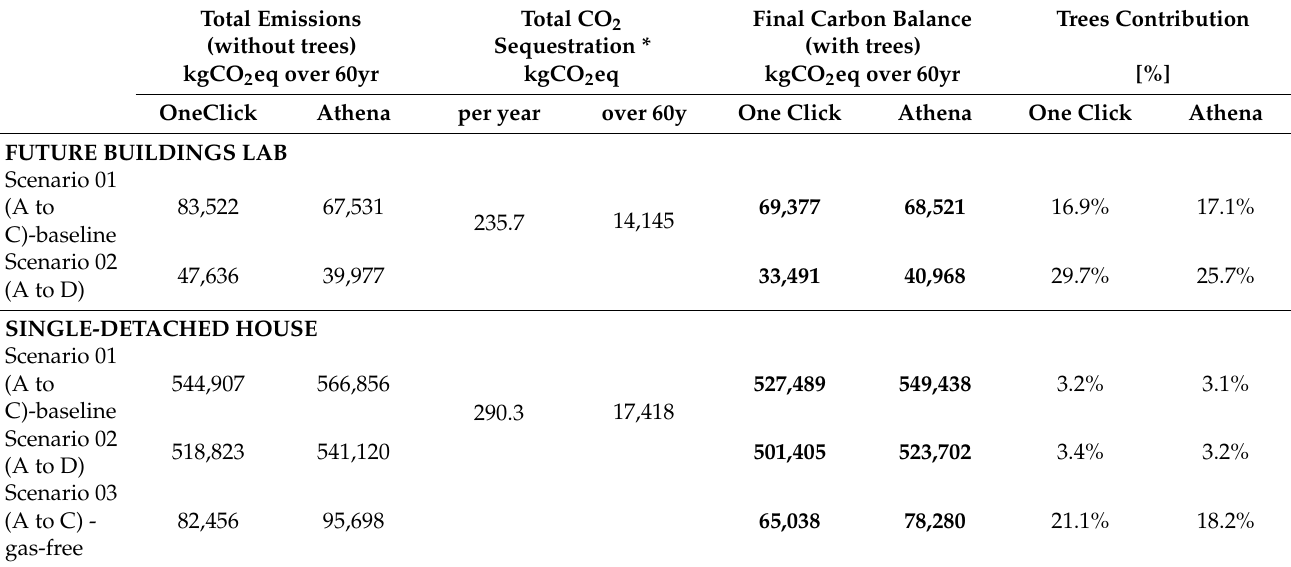
Table 10. Summary of results and contribution of trees on reducing buildings’ life cycle carbon